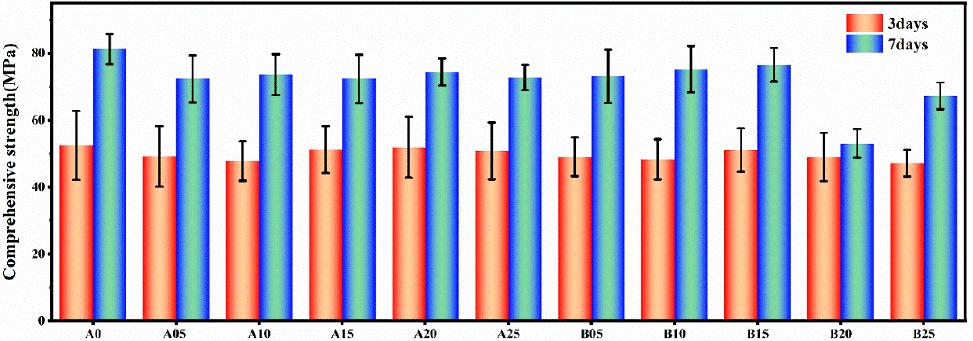
Figure 7. Compressive strength of benchmark group and defoaming group. Table 8. The compressive strength of the benchmark group and different amounts of